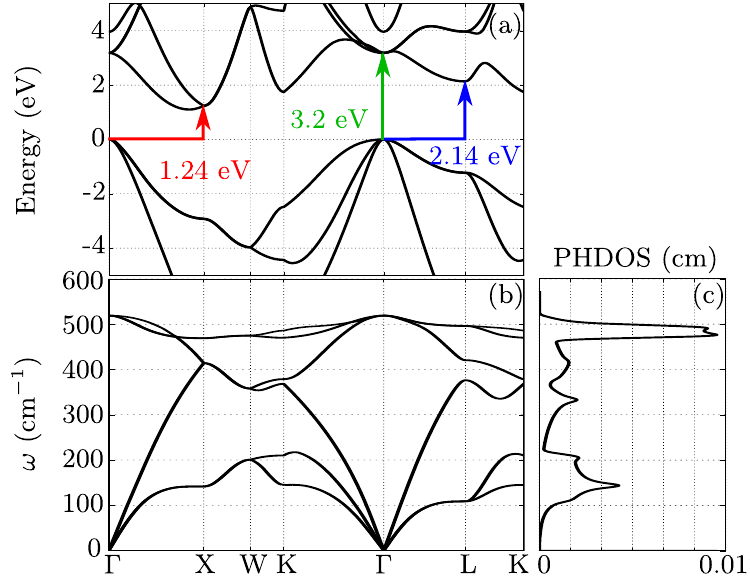
Figure 6. ( a ) Electronic Kohn-Sham band structure of silicon, with a scissor shift of 0.65 eV for the conduction bands. Possible direct transitions at Γ and indirect transitions from Γ to X and from Γ to L are indicated by the green, red, and blue arrows, respectively. ( b ) Phonon band structure and ( c ) phonon density of states.